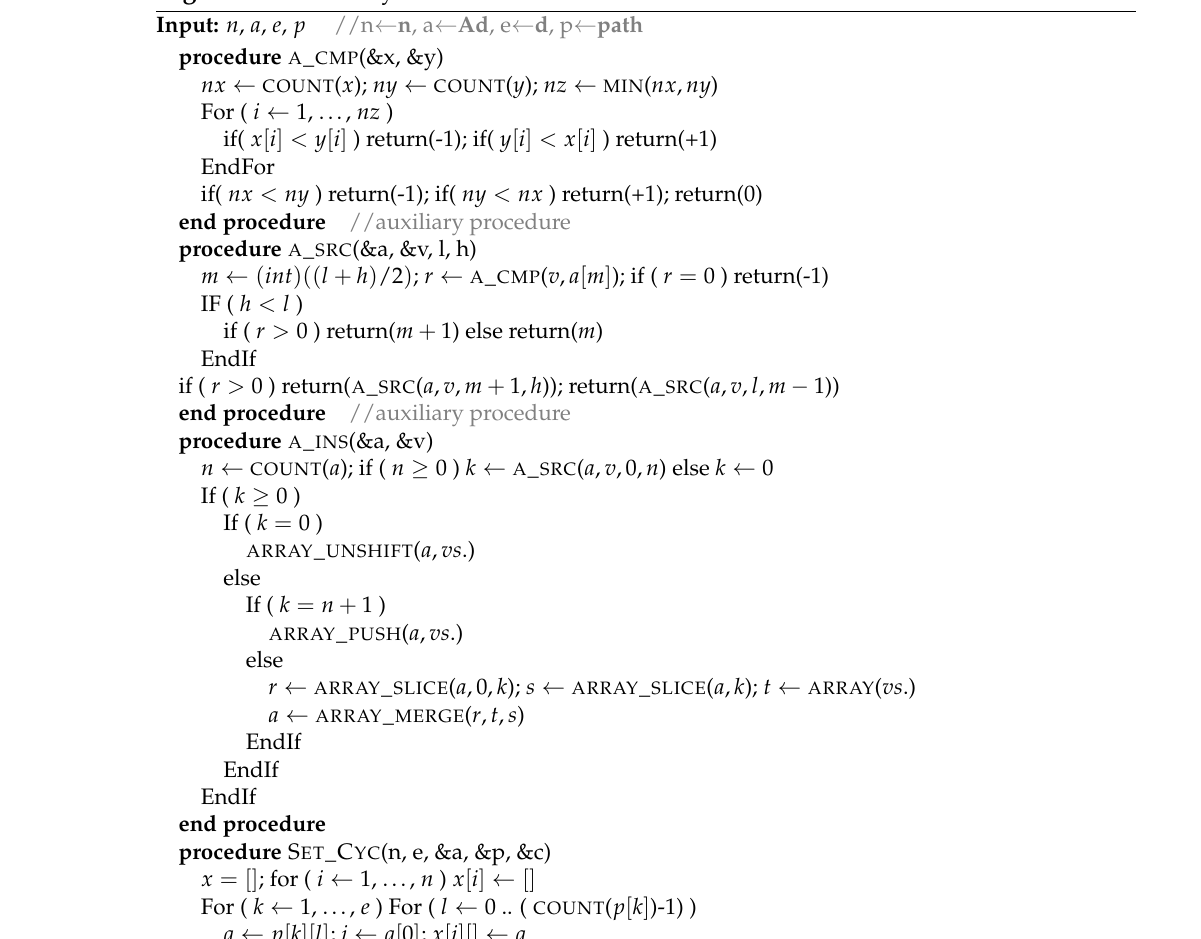
Algorithm A13 Set cycles